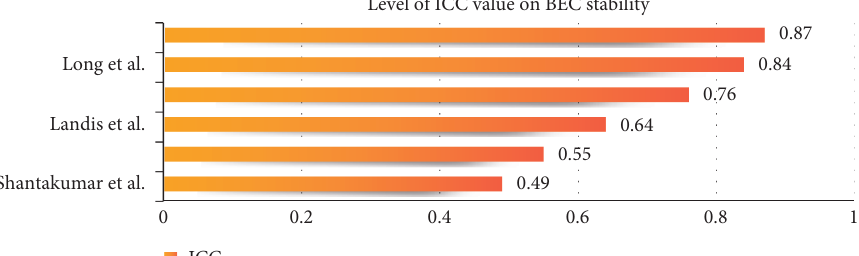
Figure 4: Level of ICC value on BEC stability from different studies. ICC, intraclass correlation coefficient. ICC value: excellent ( > 0.75), fair to good (0.40–0.75), and poor ( <